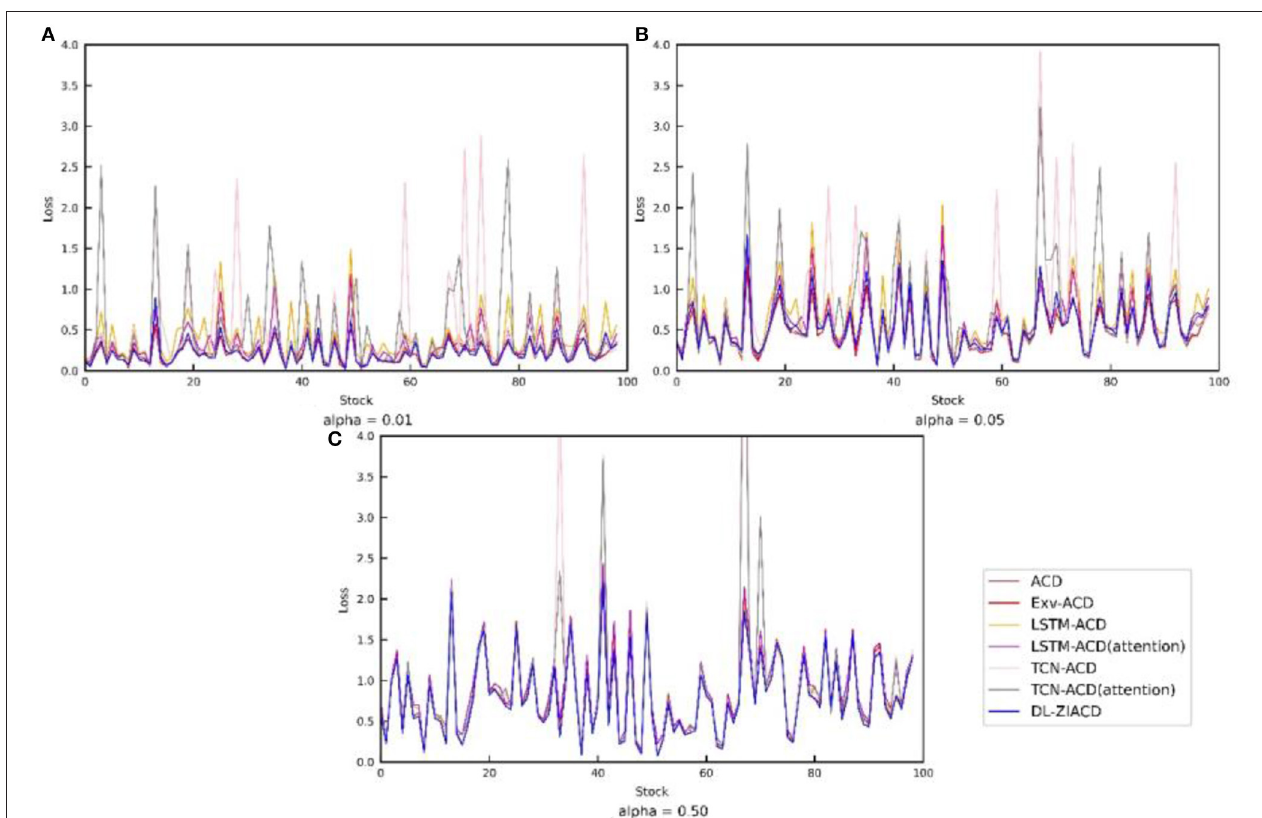
FIGURE A1 | Detailed comparison of the seven models in QL α by a line chart. (Each full line is plotted by connecting the QL α value from the corresponding model on each stock).